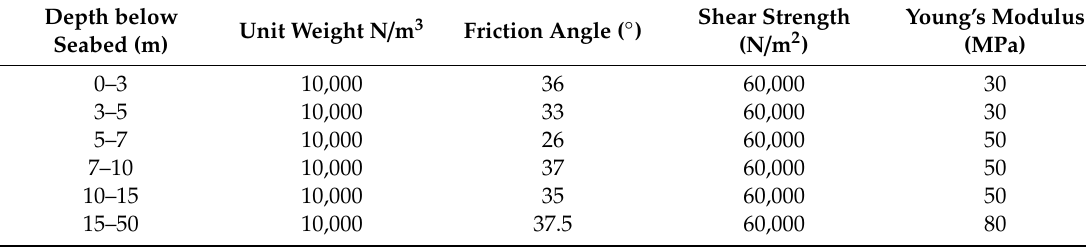
Table 5. K-13 deep-water site’s soil profile